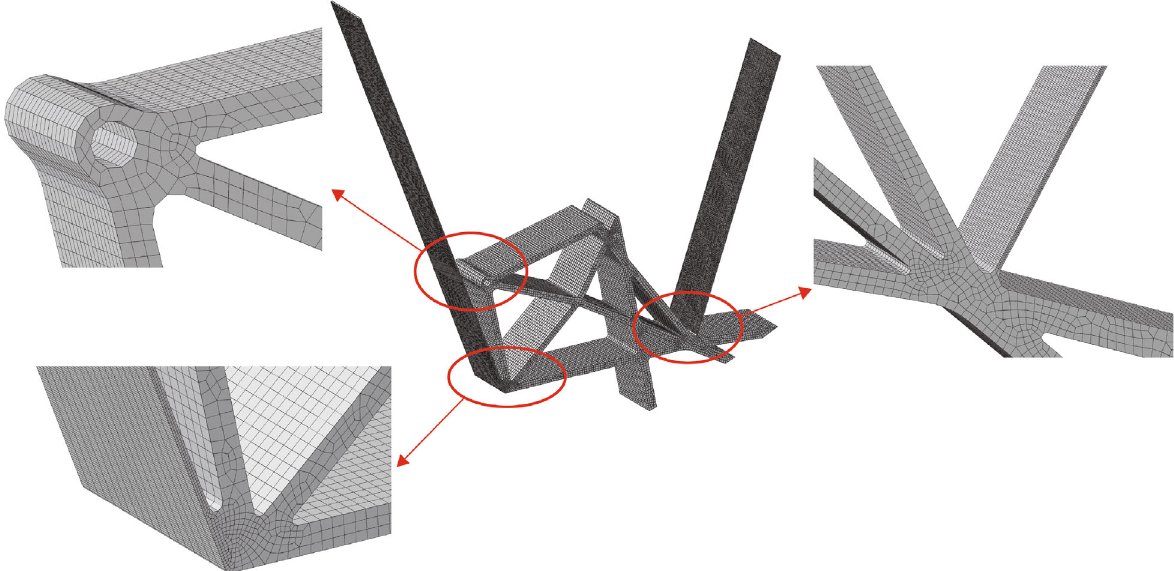
Figure 11: Detailed fi nite element model of a rib.